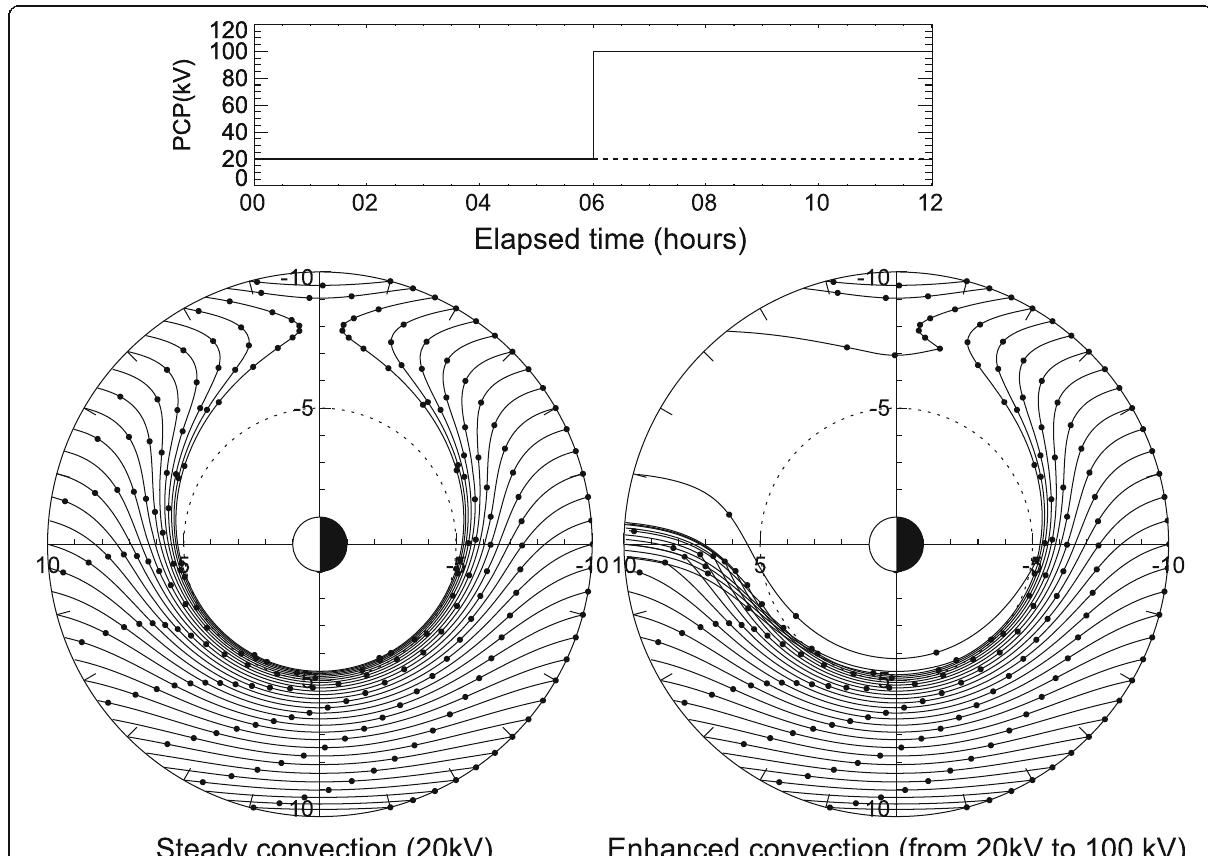
Fig. 3 Bounce-averaged drift trajectories of protons with magnetic moment of 0.030 keV/nT with initial equatorial pitch angle of 25° at L = 10 in the presence of the convection electric field, the corotation electric field, and the dipole magnetic field. A filled circle is marked every 1 h along the trajectory. (Ebihara et al. 2004)